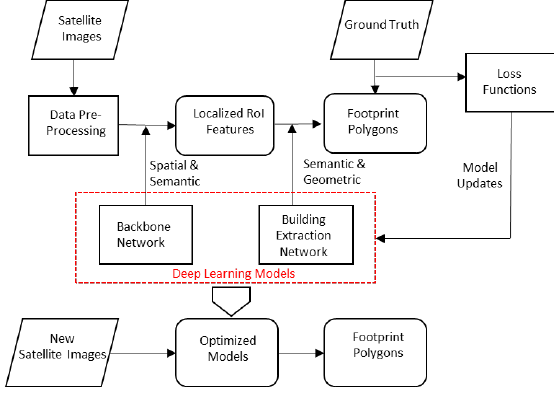
Figure 1. Framework of the